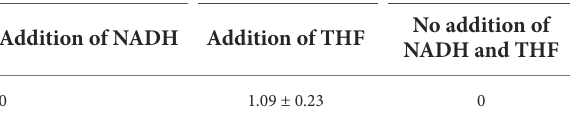
TABLE 3 Demethylase activities in cell extract of the enriched